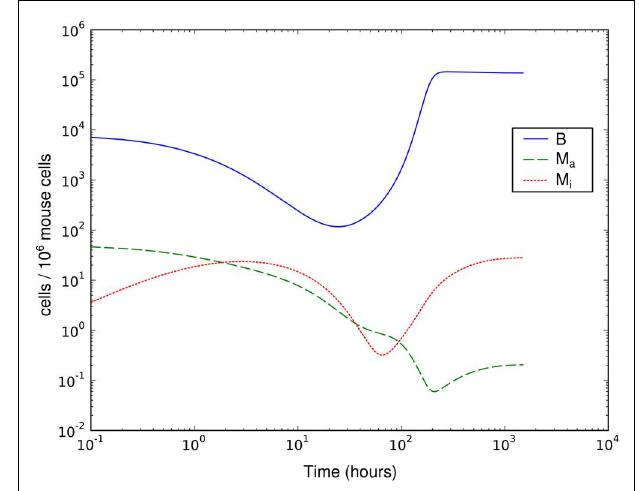
FIGURE 4 | Simulation of spirochetal dynamics in an infection at a single-site. In this model, the phagocytic capacity of the phagocytes limits the immune reaction and prevents control of the infection. B : bacteria population, M a : active phagocytes, M i : inactive